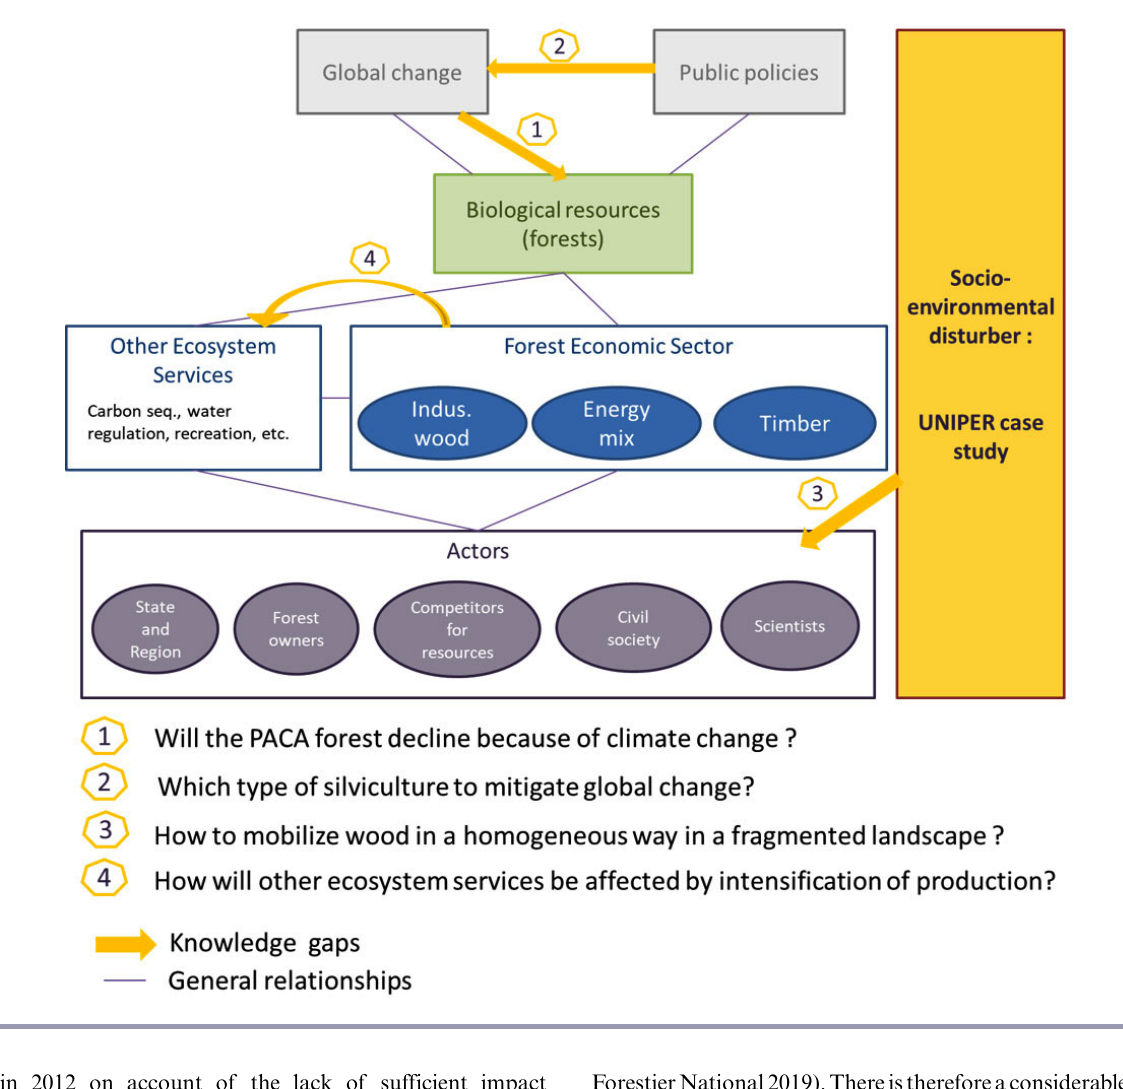
Fig. 2 . Map of the social-ecological system and gap of knowledge. PACA, Provence-Alpes-Côte d'Azur